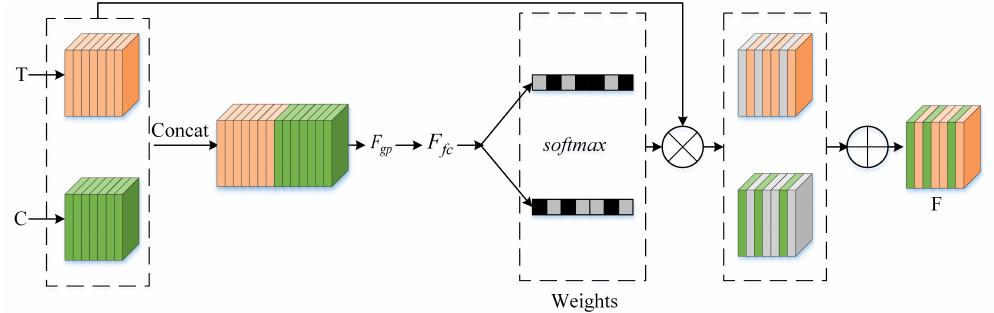
Figure 4. Illustration of multispectral channel feature fusion. The first stage of the MCFF concatenates features from the color and thermal modalities in the channel dimension. Then, the second stage uses the learning weight to aggregate features in an adaptive